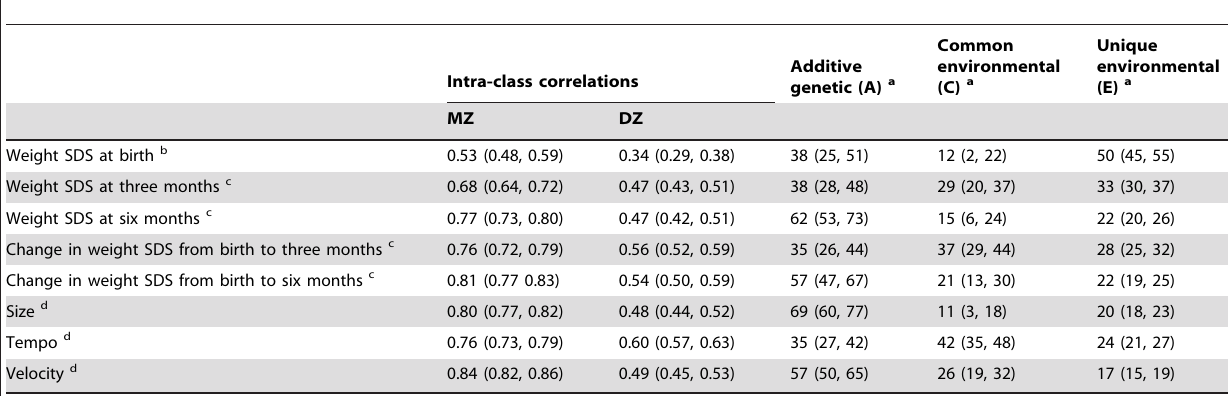
Table 2. Intra-class correlations and heritability of weight, weight change and SITAR growth parameters from birth to six months in